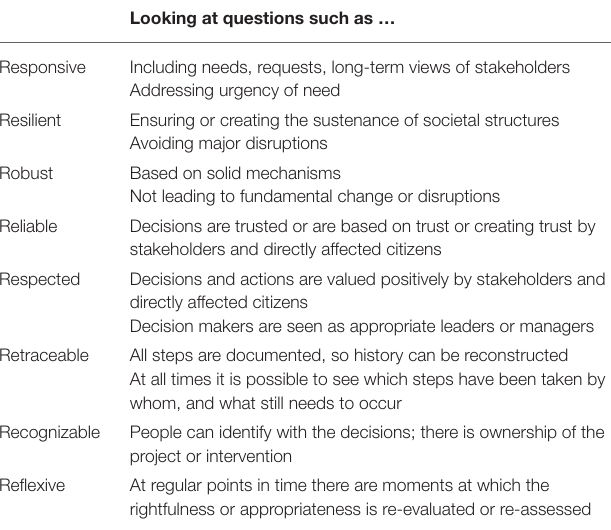
TABLE 2 | 8 R aspects of the 8R framework of responsible land management. Looking at questions such as …